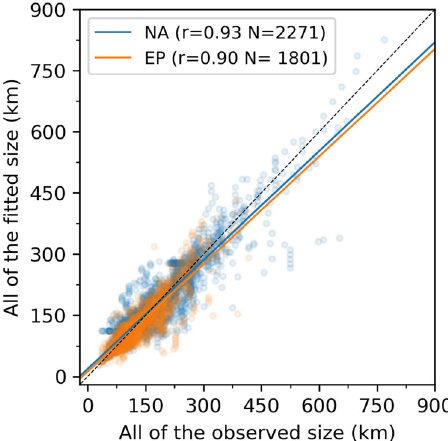
Fig. 3 Comparison between the observed R 34 in the best track and the correspondingly fi tted values of NA and EP TCs. The solid line denotes the linear least-squares fi t. The dotted line shows the y = x line. The r values in the legend are the Pearson correlation coef fi cient with the total number ( N ) of size